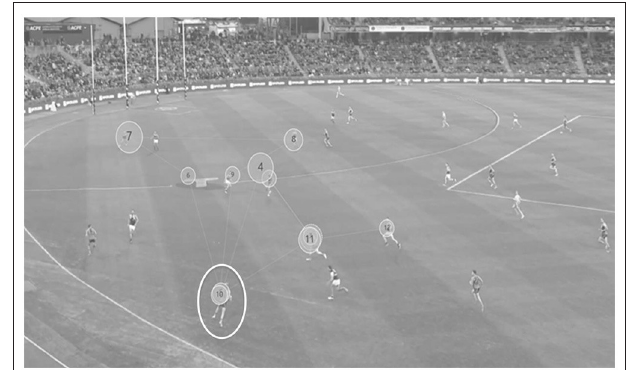
FIGURE 1 | Example Tobii Pro lab data output indicating visual search patterns. The total number of fixations to a part of the display is indicated in the circle, by chronological order. The size of size of the circles signifies the fixation duration with larger circles indicating a longer duration. The player circled in white is in possession of the ball, and the team in gray uniforms are on offense.